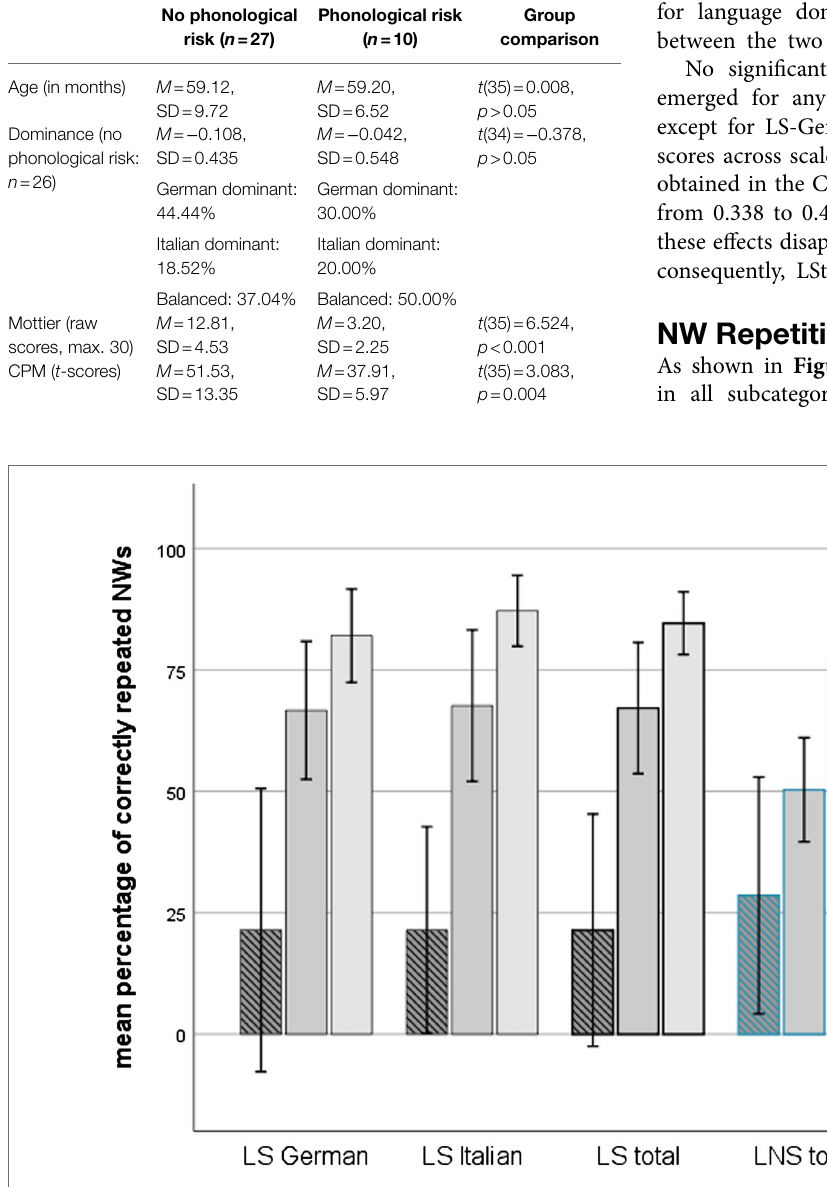
FIGURE 1 | Mean percentage of correctly repeated NWs for each MuLiMi NWRT scale according to clinical/risk status at T1. Error bars represent 1 SD. TD: n = 13; at-risk: n = 17; and DLD: n = 7.